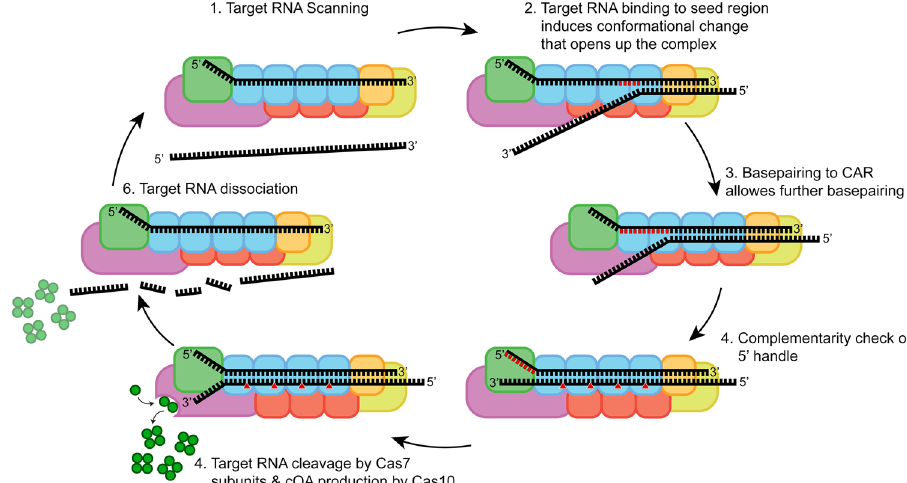
Fig. 6 Schematic model of TtCmr target binding and subsequent activities. ( 1 ) TtCmr complex with bound crRNA is scanning for complimentary target RNA. ( 2 ) Target RNA binding is initiated at seed region, which induces a conformational change that allows further base pairing. ( 3 ) Full base pairing of target RNA to the crRNA, activating Cas10. ( 4 ) Target RNA is cleaved by Cas7 subunits and cOA is produced by Cas10. ( 5 ) Cleaved target RNA dissociates from